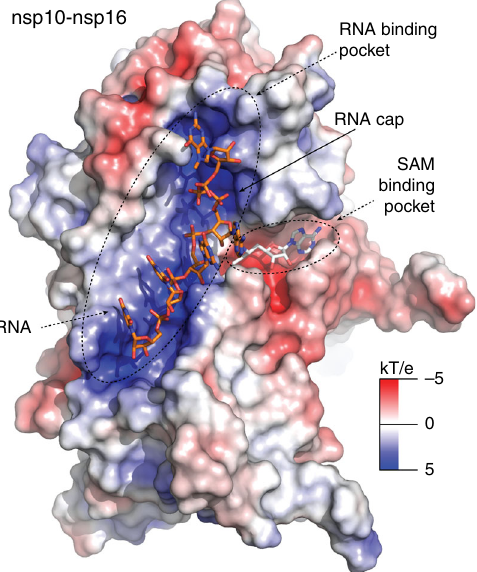
Fig. 5 Model of RNA recognition by the nsp10-nsp16 complex. The surface of the nsp10-nsp16 was colored according to the electrostatic surface potential. Sinefungin is localized in the SAM binding pocket. The RNA binding pocket is characterized by a positively charged surface that interacts with the RNA phosphate backbone. The RNA cap is located at the top of the RNA binding pocket while the active site is located at the interface of the RNA and SAM binding pockets. The RNA was modeled in the RNA binding pocket based on a structural alignment of SARS-CoV-2 MTase with Dengue MTase (PDB code 5dto) and manually adjusted in